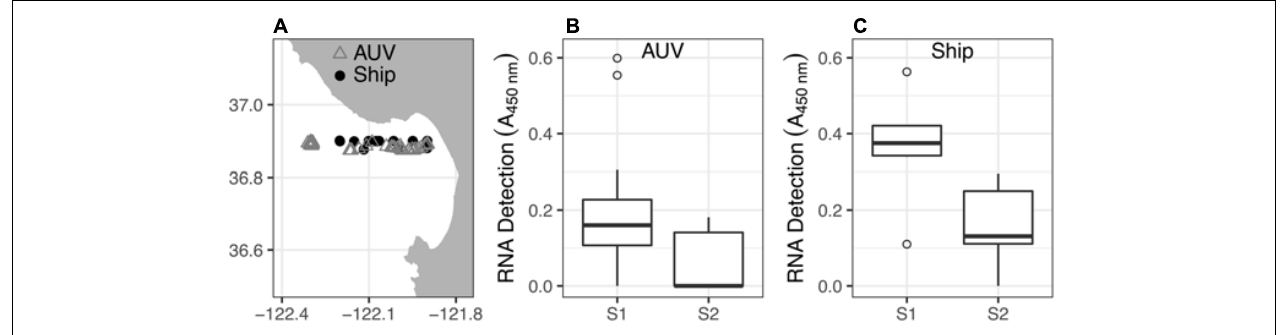
FIGURE 4 | Calanoid copepod RNA detection (biomass) from water samples collected by AUV and ship. (A) Map of all sample locations. (B) Non-parametric boxplots of sample calanoid copepod RNA signals from AUV water samples collected during sampling periods S1 ( n = 27) and S2 ( n = 10), corresponding to Figures 3A–F , respectively). (C) Non-parametric boxplots of RNA signals from ship water samples collected during S1 ( n = 7) and S2 ( n =